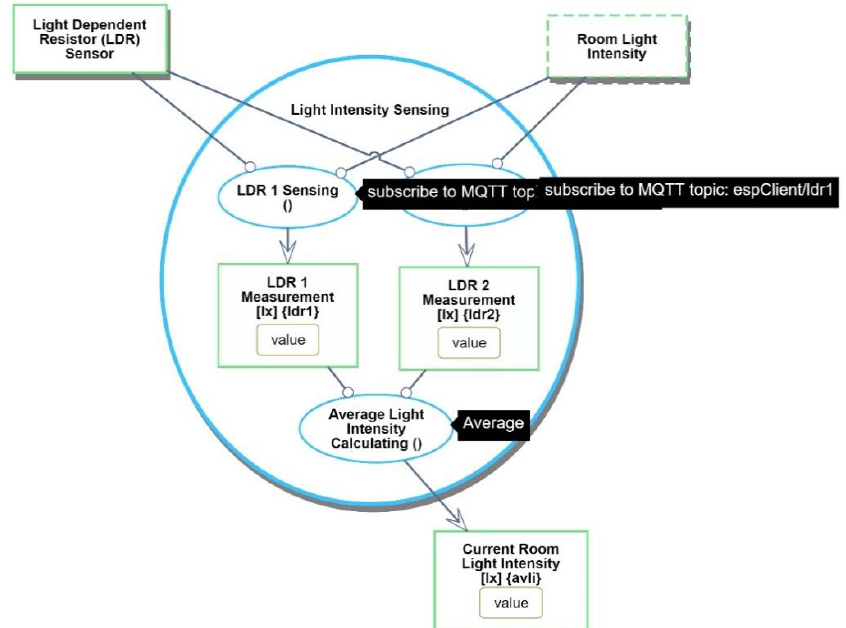
Figure 20. SD1.1 inzooming into the Light Intensity Sensting process.